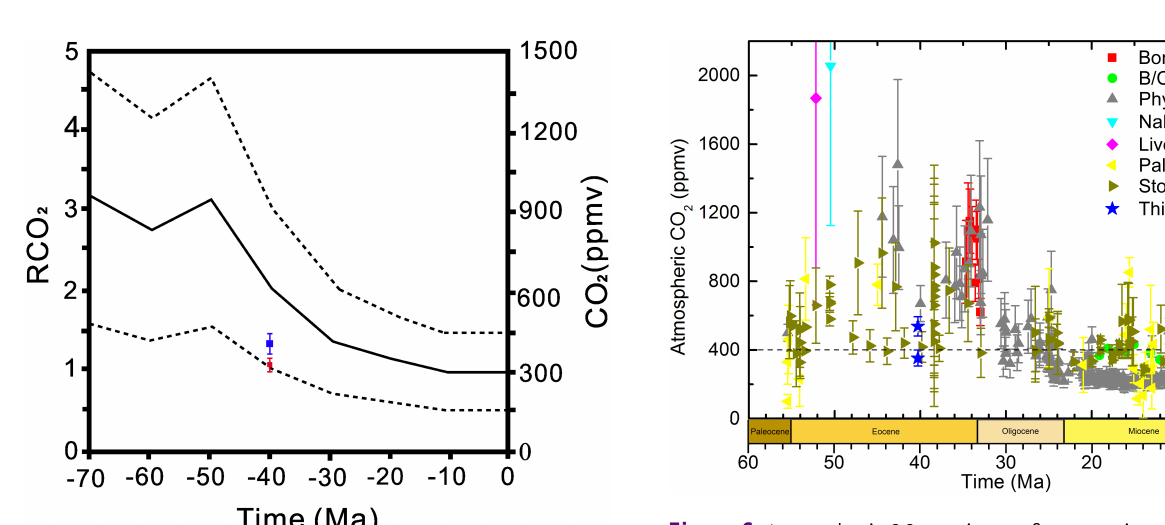
Figure 6. Atmospheric CO 2 estimates from proxies over the past 60 million years. The horizontal dashed line indicates monthly atmospheric CO 2 concentration for March 2015 at Mauna Loa, Hawaii (401.5ppmv) (Pieter and Keeling, 2015). The vertical lines show the error bars. The data are from the supporting data of Beer- ling and Royer (2011) and references in Table 9. The lower blue star shows the reconstructed result based on the regression approach. The higher one presents the result of stomatal ratio method.